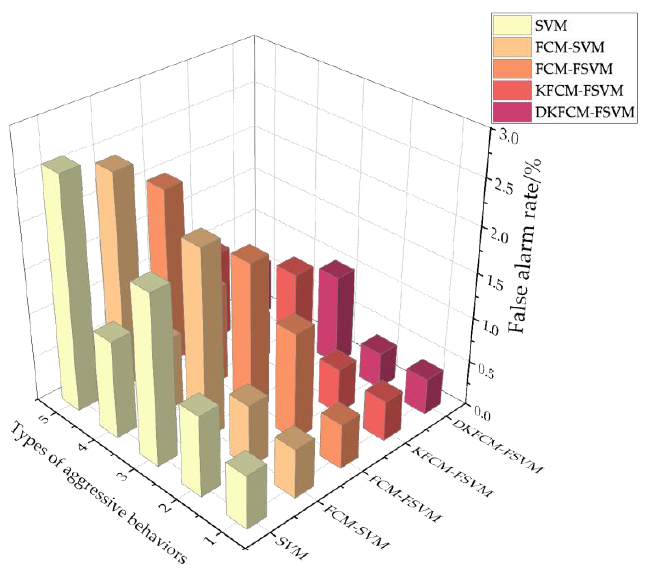
Figure 8. The false positive rate of the wireless sensor network algorithm models. The false negative rate represents the proportion of abnormal behaviors that were not recognized and detected. The comparison results of the various algorithms are shown in Figure 9. Compared with the other calculations, the DKFCM-FSVM calculated and identified five kinds of behaviors, and the false negative rate of the intrusion detection was 0.004, 0.003, 0.003, 0.008, and 0.005 respectively, which was low as a whole. The SVM algorithm had a high false negative rate, followed by the FCM-SVM algorithm. In the WSN environment, most of the behaviors were normal, and the abnormal data generated by the intrusion attack accounted for a very small number. In most cases, they were linear and indivisible, and the kernel function needed to be mapped to the high-dimensional space. The detection effect of the SVM was poor. The FCM was sensitive to the selection of the initial clustering and unbalanced datasets, and the effect was not good. The DKFCM-FSVM algorithm effectively avoided the impact of the noise and the outliers on the classification results by introducing the data density and feature distance and achieved the optimal classification results.